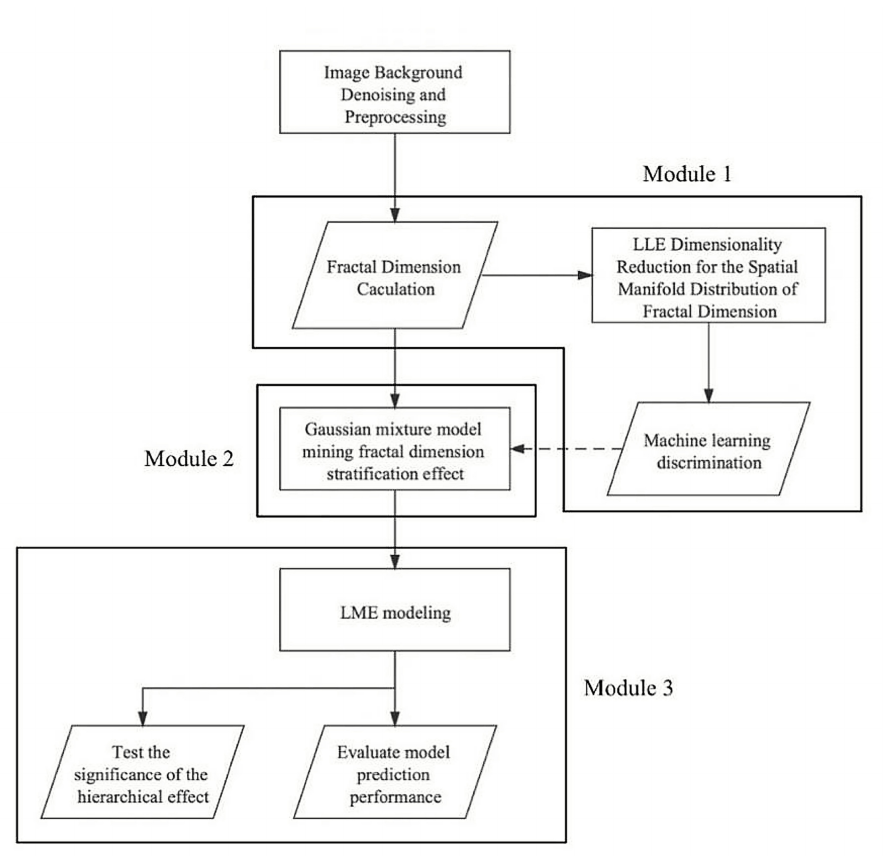
Figure 1. The framework of the ML-LME